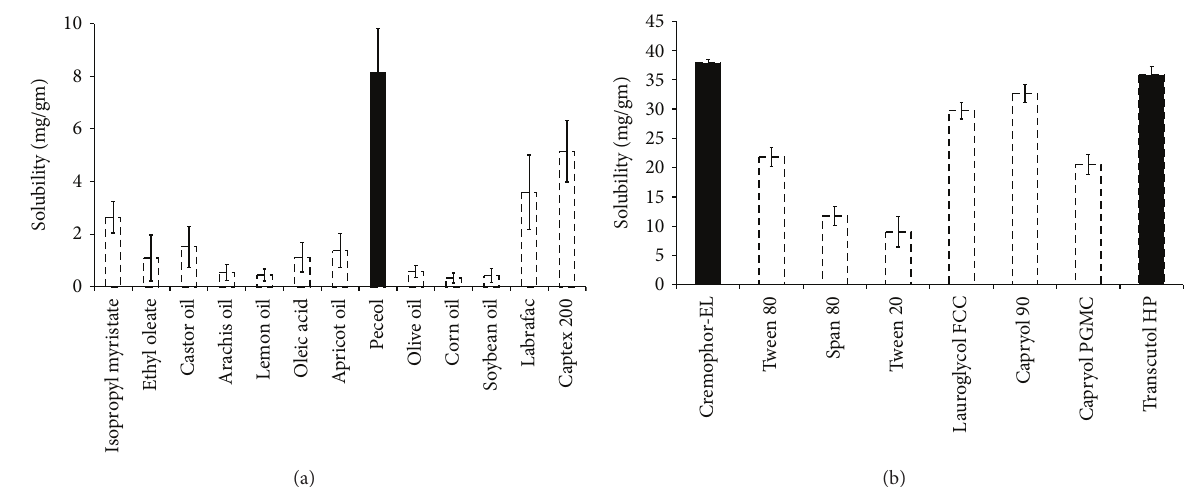
Figure 1: Solubility profile of CUR in different vehicles: (a) lipids, (b) surfactants and cosurfactants.